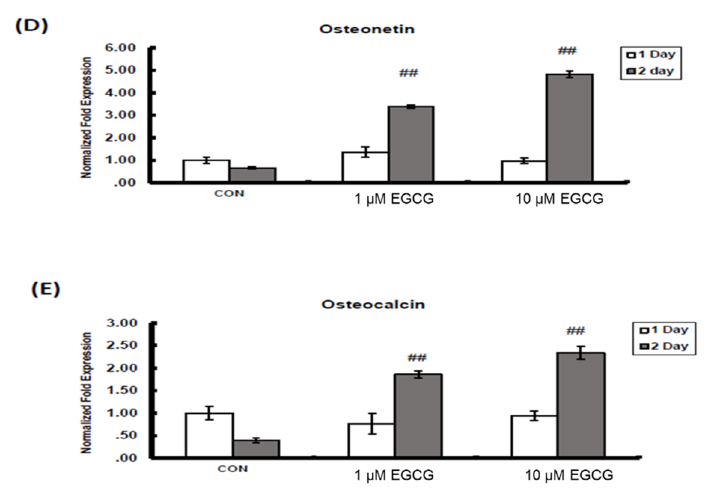
Figure 2. The mRNA expression of osteogenic marker genes. The mRNA expression of Runx2 ( A ), bone morphogenetic protein 2 (BMP2) ( B ), ALP ( C ), osteonectin ( D ) and osteocalcin ( E ) increased significantly after EGCG treatment for 24 and 48 h, at concentrations of both 1 and 10 µ mol/L. The expression of BMP2, Runx2, alkaline phosphatase (ALP), osteonectin and osteocalcin were quantified by real-time PCR. There were significant changes in all genes after treatment for 48 h but not 24 h, except in the case of Runx2. In Runx2, mRNA expression increased 57% ( p < 0.01) and 85% ( p < 0.05) with 1 and 10 µ mol/L, respectively, at 24 h and 169% ( p < 0.01) and 203% ( p < 0.01) with 1 and 10 µ mol/L, respectively, at 48 h. In BMP2, mRNA expression increased 459% ( p < 0.01) and 502% ( p < 0.01) with 1 and 10 µ mol/L, respectively. ALP mRNA expression was enhanced 239% ( p < 0.01) and 210% ( p < 0.01) at concentrations of 1 and 10 µ mol/L of EGCG, respectively. The mRNA expression in osteonectin was amplified 239% ( p < 0.01) and 383% ( p < 0.01) after EGCG treatment at concentrations of 1 and 10 µmol/L, respectively. The mRNA expression in osteocalcin was amplified 86% ( p < 0.01) and 134% ( p < 0.01) after EGCG treatment at concentrations of 1 and 10 µmol/L, respectively. # p < 0.05, ## p < 0.01.